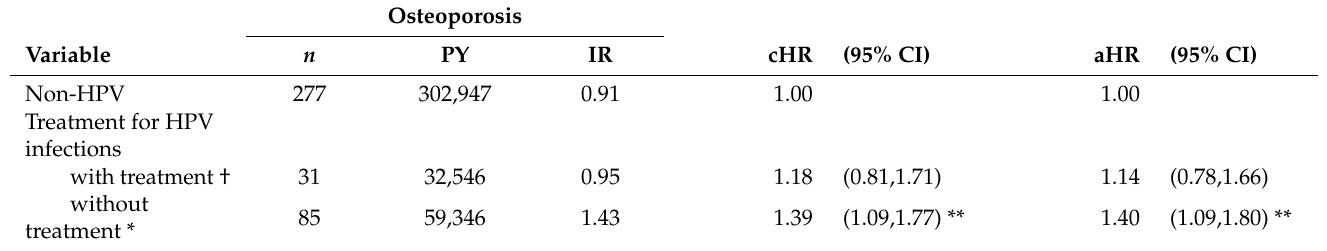
Table 4. Risk of osteoporosis in HPV-infected patients with or without treatments for HPV infections.